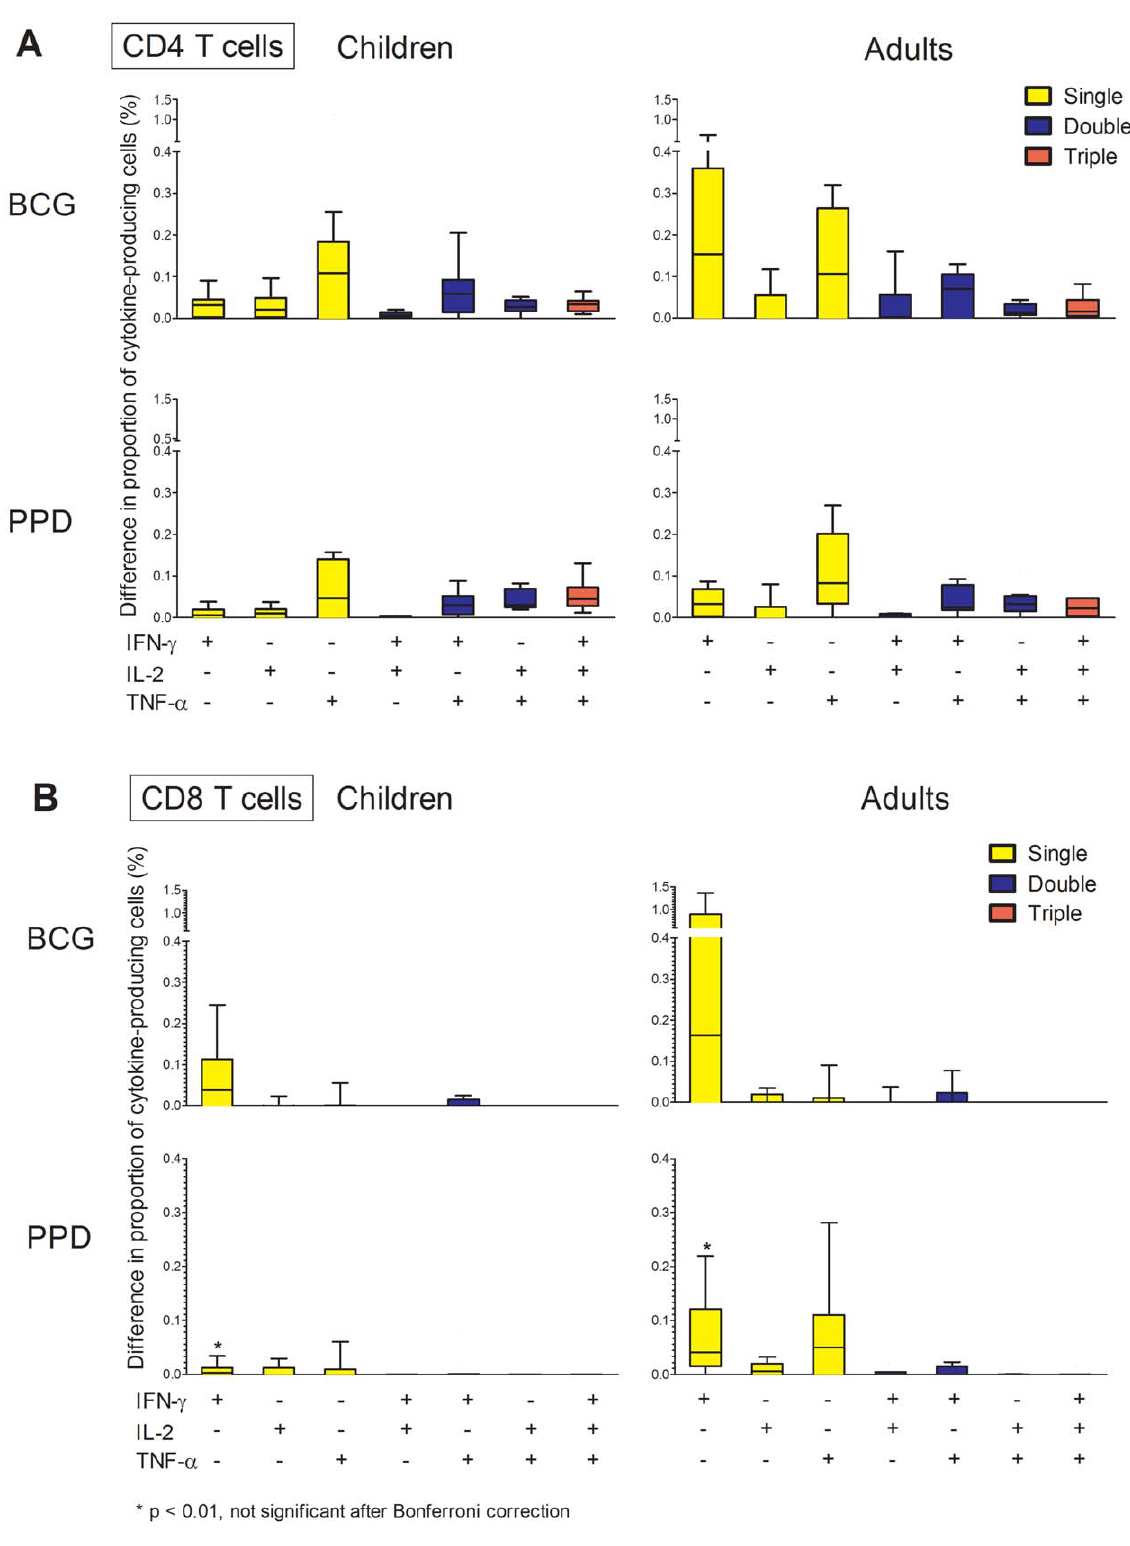
Figure 4. Box plots (with lower quartile, median and upper quartile, whiskers 1.5 IQR) showing median change in the proportion of cytokine-producing subpopulations of CD4 T cells 10 weeks after BCG immunisation in children (n=13) and adults (n=13). The proportion of Th1-cytokine-producing subpopulations in CD4 and CD8 T cells was measured following in vitro stimulation with the antigens BCG and PPD, in whole blood taken before and after BCG immunisation. The median change for (A) CD4 and (B) CD8 T cells was calculated by subtracting results before BCG immunisation from results after BCG immunisation. Differences were compared using a Mann-Whitney test.